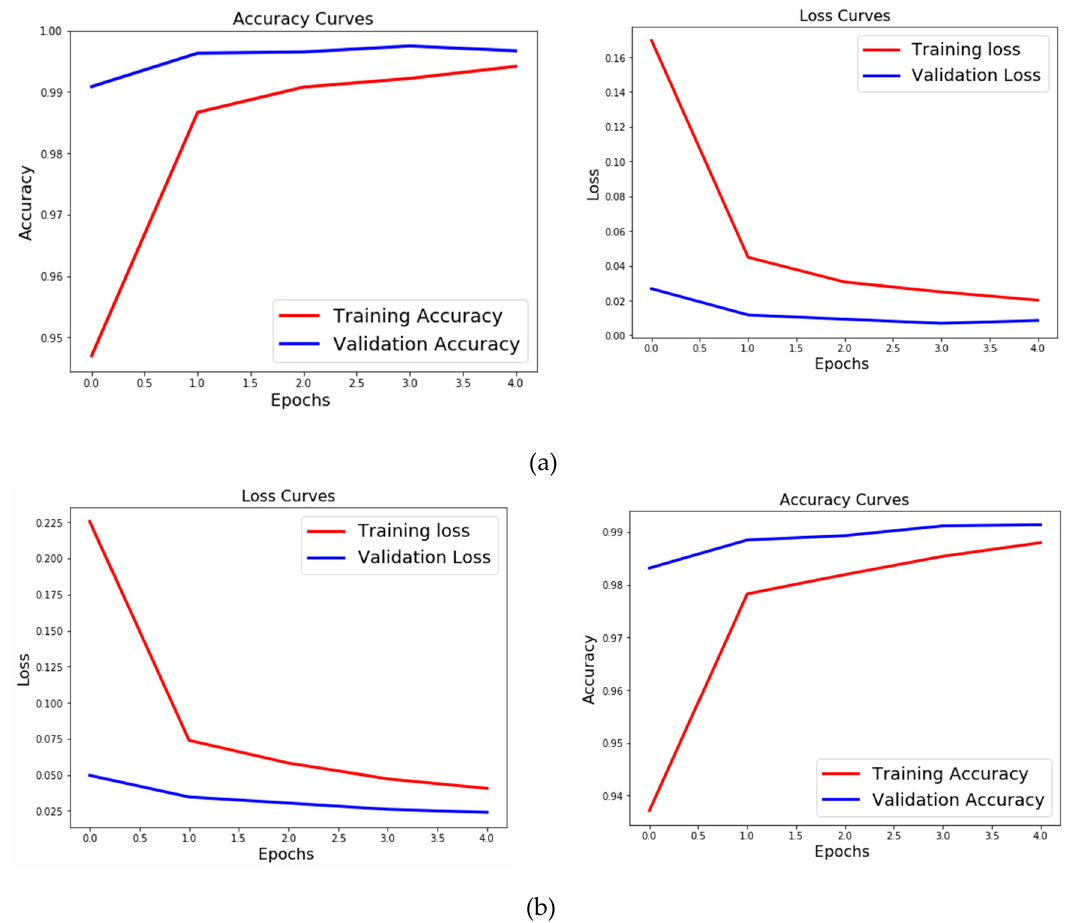
Figure 6. Performance curves for knowledge-transfer model. ( a ) Performance curves for basic knowledge-transfer model for accuracy ( left ) and loss ( right ); ( b ) performance curves for transferred knowledge-transfer model for accuracy ( left ) and loss ( right ). Table 24. Comparison of neural networks.